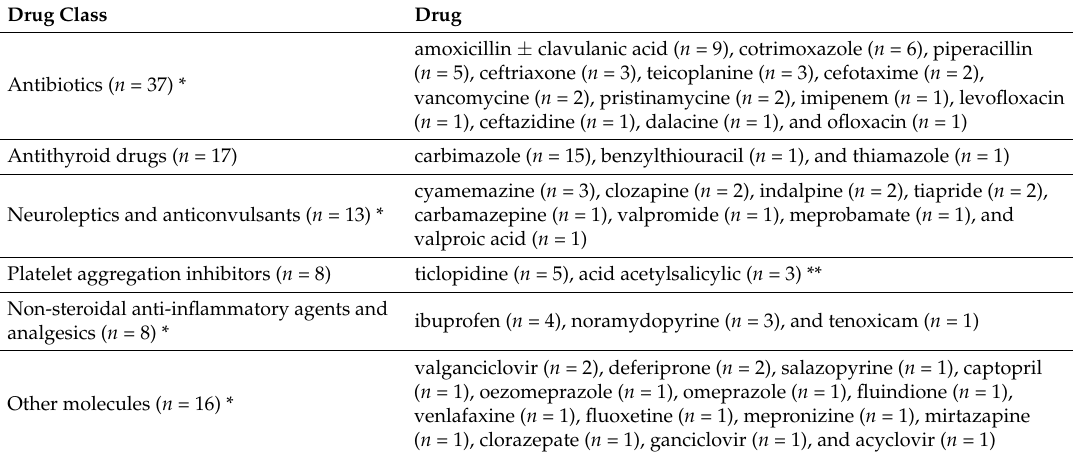
Table 2. Drugs incriminated in febrile neutropenia related to non-chemotherapy